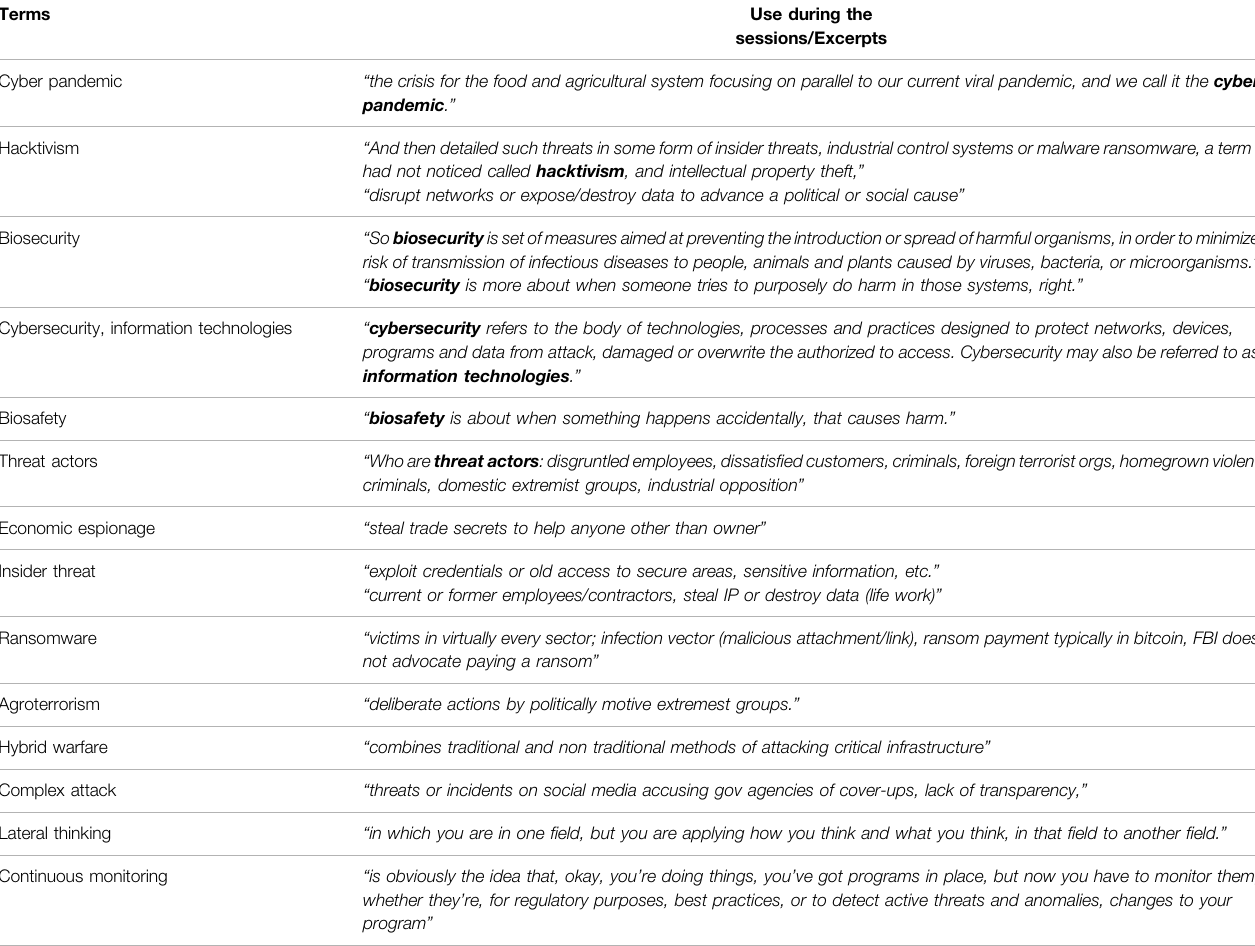
TABLE 2 | Vocabulary terms identi fi ed as needed de fi ning by some participants and the context in which terms were used during the Securing Agriculture and Food Economy (SAFE) with Cyberbiosecurity virtual workshop (October 6 – 7,